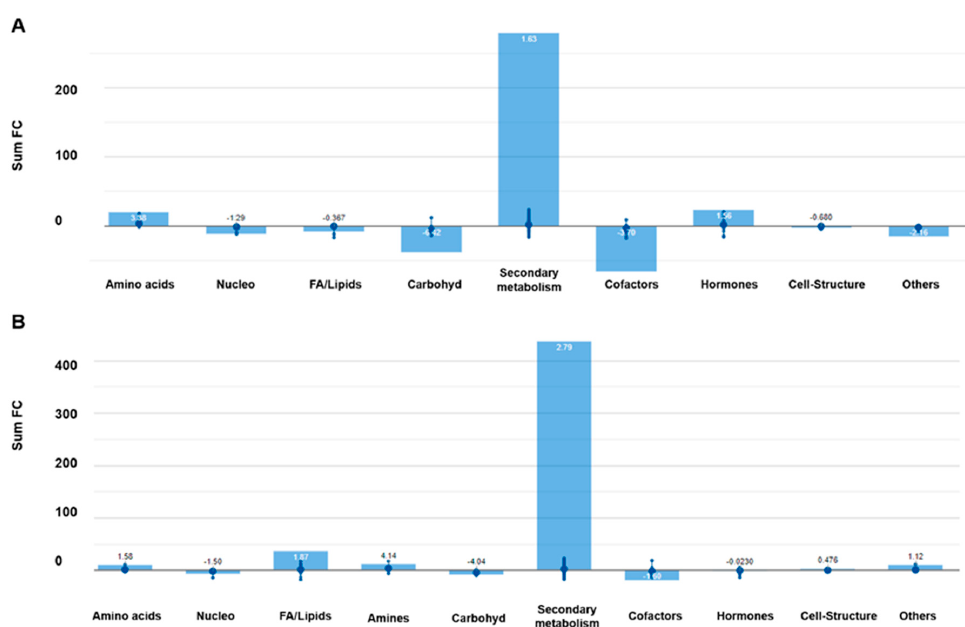
Figure 4. Processes affected by the light intensity in ‘Red’ ( A ) and ‘Green Salanova’ ( B ). Differential metabolites and their fold-change (FC) values were elaborated using the Omic Viewer Dashboard of the PlantCyc pathway Tool software (www.pmn.plantcyc.com). In each class, the large dot represents the average (mean) logFC of the metabolites. Small dots represent the individual logFC for each metabolite. The abbreviated subcategory names reported on the x -axis correspond to: Nucleo: nucleosides and nucleotides; FA / Lipids: fatty acids and lipids; Amines: amines and polyamines; Carbohyd: carbohydrates; Cofactors: cofactors, prosthetic groups, electron carriers and